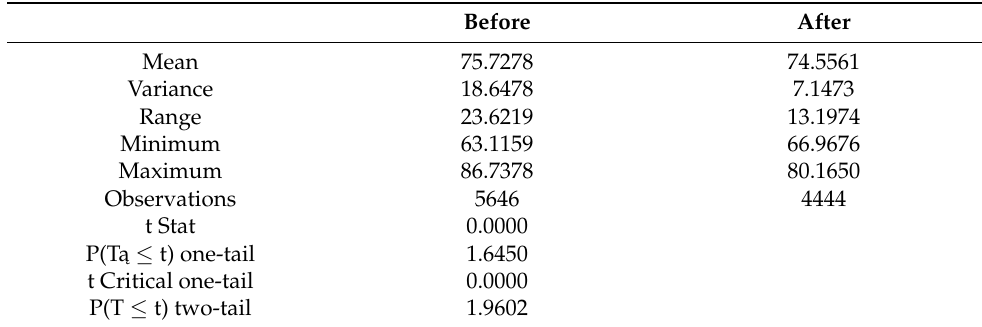
Table 3. t -Test: Two-Sample Assuming Unequal Variances.